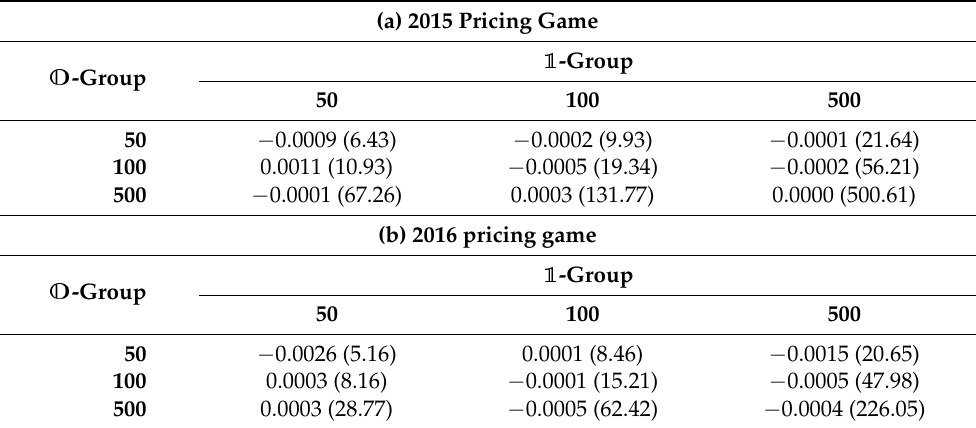
Table 8. Bias and run time (s), the latter between brackets, for the approximation ˆC the 2015 and 2016 pricing game dataset. This is given for the weighted-mean-plot approach and for several different numbers of clusters for the O - and 1